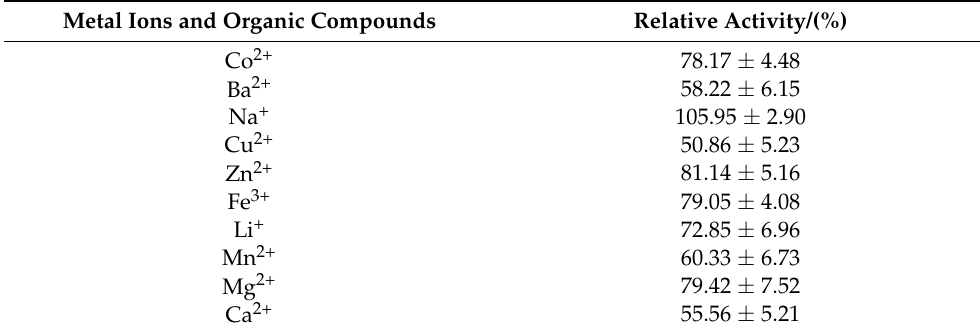
Table 3. Effect of metal ions on KoFAE enzyme activity. Table 3. E ff ect of metal ions on KoFAE enzyme activity. Metal Ions and Organic Metal ions and Organic Compounds